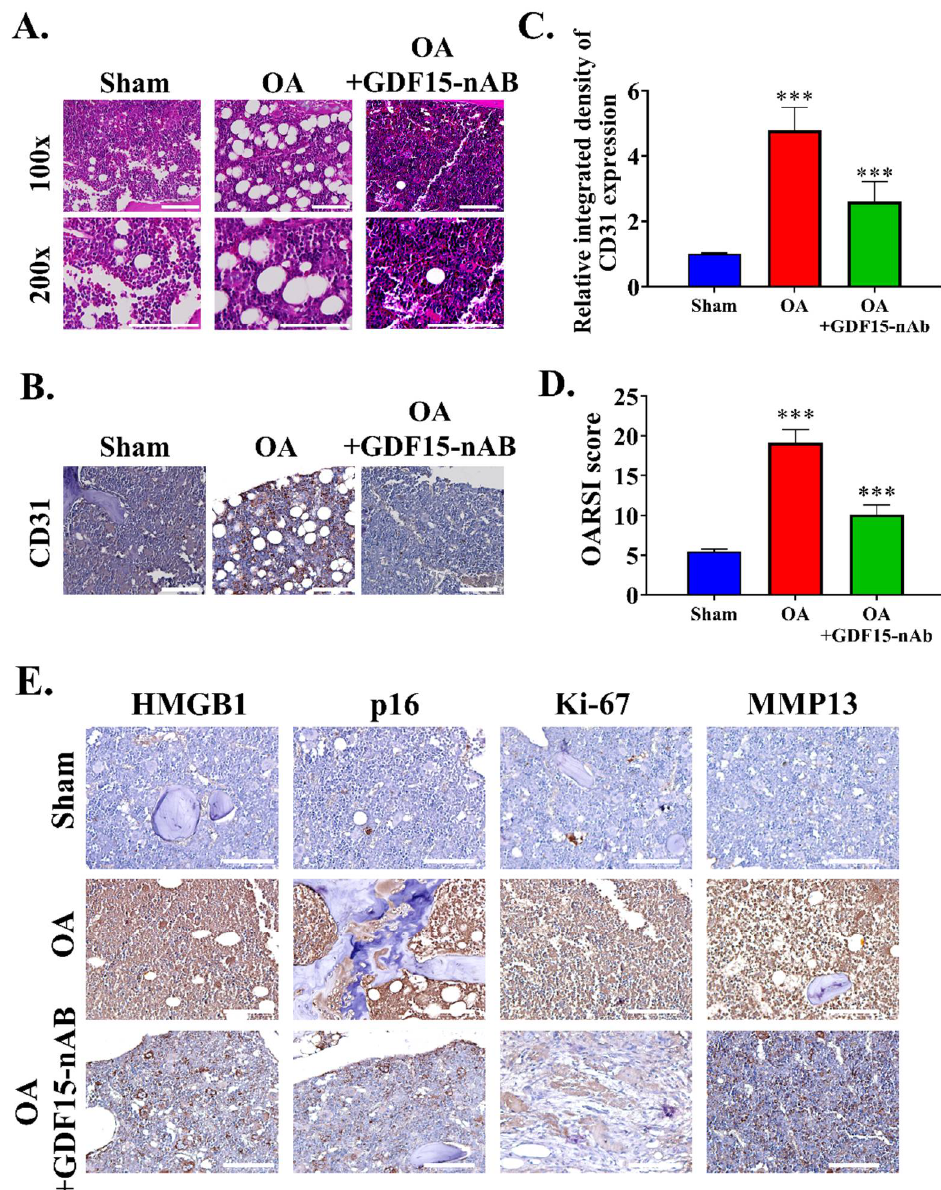
Figure 7. GDF15-nAb inhibits angiogenesis and attenuates posttraumatic OA in rat. ( A ) Hematoxylin and eosin staining of OA rat after GDF15-nAb therapy (scale bar, 50 or 100 µ m). Scale bar: 100 µ m ( B ) IHC examination of CD31 detection and positive region of knee joints from treated ACLT rat (Scale bar, 25 µ m). Scale bar: 100 µ m ( C ) OARSI score quantification of each groups. ( D ) Quantification of CD31-positive cells in each group. ( E ) Representative immunostaining images of HMGB1 ( n = 5 for each group), p16INK4a ( n = 5 for each group), Ki-67 ( n = 5 for each group), and MMP13 ( n = 5 for each group) in the articular cartilage from no surgery ( n = 5), and ACLT rat treated with vehicle ( n = 5) or GDF15-nAb ( n = 5). Scale bar: 100 μm. *** p < 0.001.